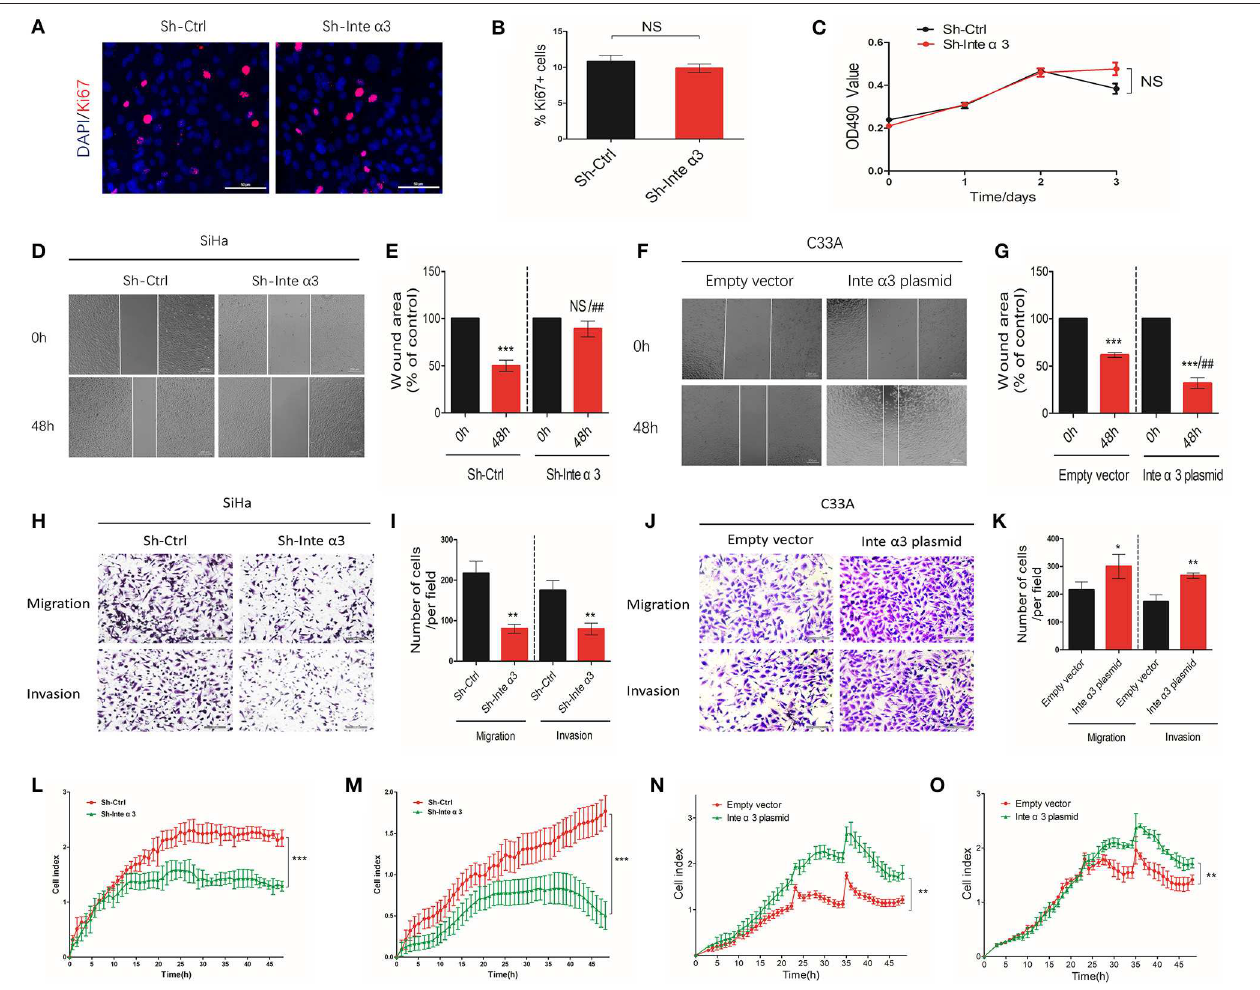
FIGURE 3 | Integrin α 3 promotes the migration and invasion, but not proliferation, of cervical cancer cells in vitro . (A) SiHa cells were treated with control shRNA (Sh-Ctrl) and integrin α 3-shRNA (Sh-Inte α 3). Subsequently, immunofluorescence staining of cells with Ki-67 was performed to investigate cell proliferation. (B) Quantification of Ki-67-positive cells per field in (A) (original magnification: × 100). (C) The MTT assay was used to analyze the proliferation rate between the Sh-Ctrl and Sh-Inte α 3 groups. (D) The wound healing assay was applied in SiHa cells to explore the effect of integrin α 3 on cell migration in vitro in the Sh-Ctrl and Sh-Inte α 3 groups, respectively. (E) Quantification of the wound area in (D) . (F) The wound healing assay was applied in C33A cells to explore the effect of integrin α 3 on cell migration in vitro in the empty vector and Inte α 3 plasmid groups. (G) Quantification of the wound area in (F) . (H–K) Transwell migration and invasion assays were performed to investigate the effect of integrin α 3 on the migration and invasion of cervical cancer cells either knocking down in SiHa or overexpressing in C33A. Quantification results of the migration and invasion of cells per field in (I,K) . (L,M) Migration and invasion were tested in the Sh-Ctrl and Sh-Inte α 3 groups through real-time migration/invasion monitoring. (N,O) Migration and invasion were tested in empty vector and Inte α 3 plasmid groups through real-time migration/invasion monitoring. All experiments were repeated thrice with consistent results, and the representative images are shown. * P < 0.05 vs. corresponding control; ** P < 0.01; *** P < 0.001; ## P <